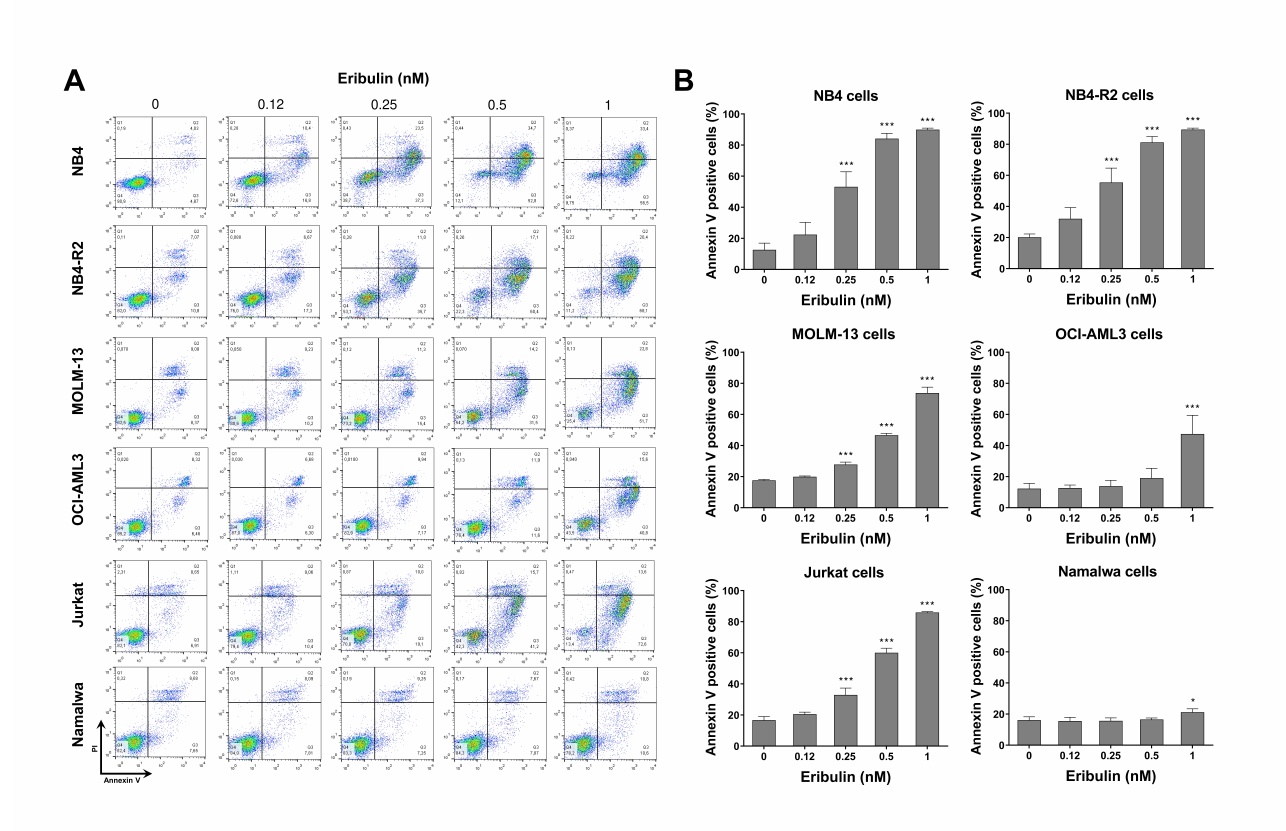
Figure 2. Eribulin triggers apoptosis in leukemia cells. ( A ) Apoptosis was detected by flow cytometry in NB4, NB4-R2, MOLM-13, OCI-AML3, Jurkat, and Namalwa cells treated with graded concentra- tions of eribulin (0.12, 0.25, 0.5, and 1 nM) for 72 h using the annexin V/propidium iodide staining method. Representative dot plots are shown for each condition; the upper and lower right quadrants (Q2 + Q3) cumulatively contain the apoptotic population (annexin V + cells). ( B ) Bar graphs represent the mean ± SD of at least four independent experiments quantifying apoptotic cell death. The p values and cell lines are indicated in the graphs; * p < 0.05, *** p < 0.0001; ANOVA test and Bonferroni